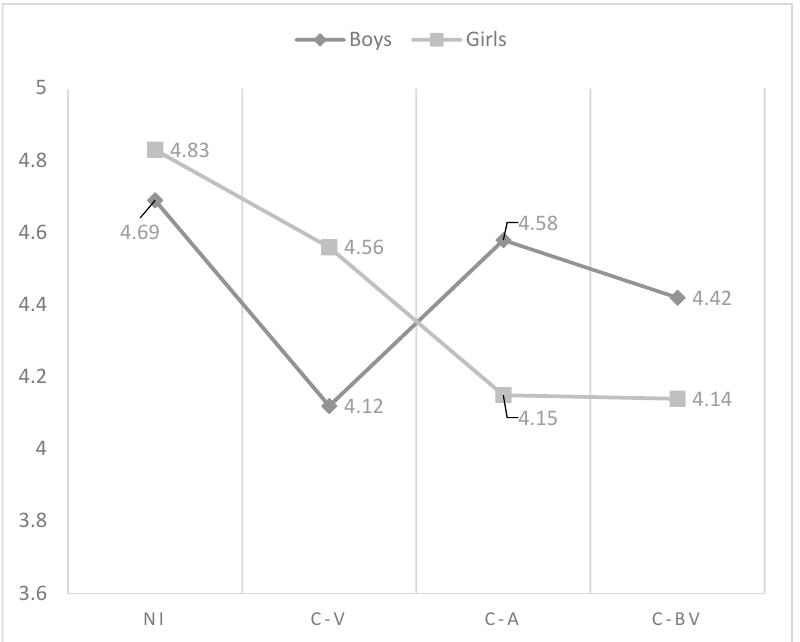
Figure 7. Effect of the interaction of gender and cyberbullying roles on father promotion of autonomy.